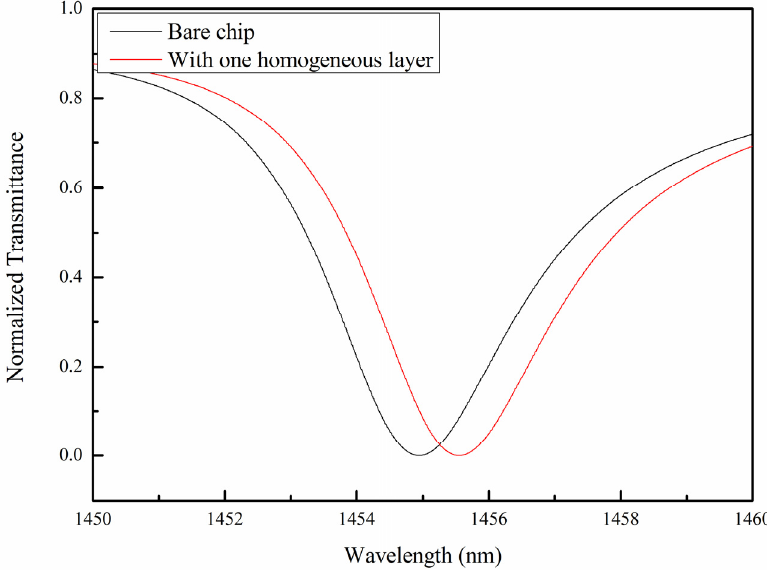
Figure 3. RCWA simulation results with (red) and without one homogeneous layer (black) on top of the GMR chip in water. The results show that the resonance wavelength shifted to a longer wavelength.